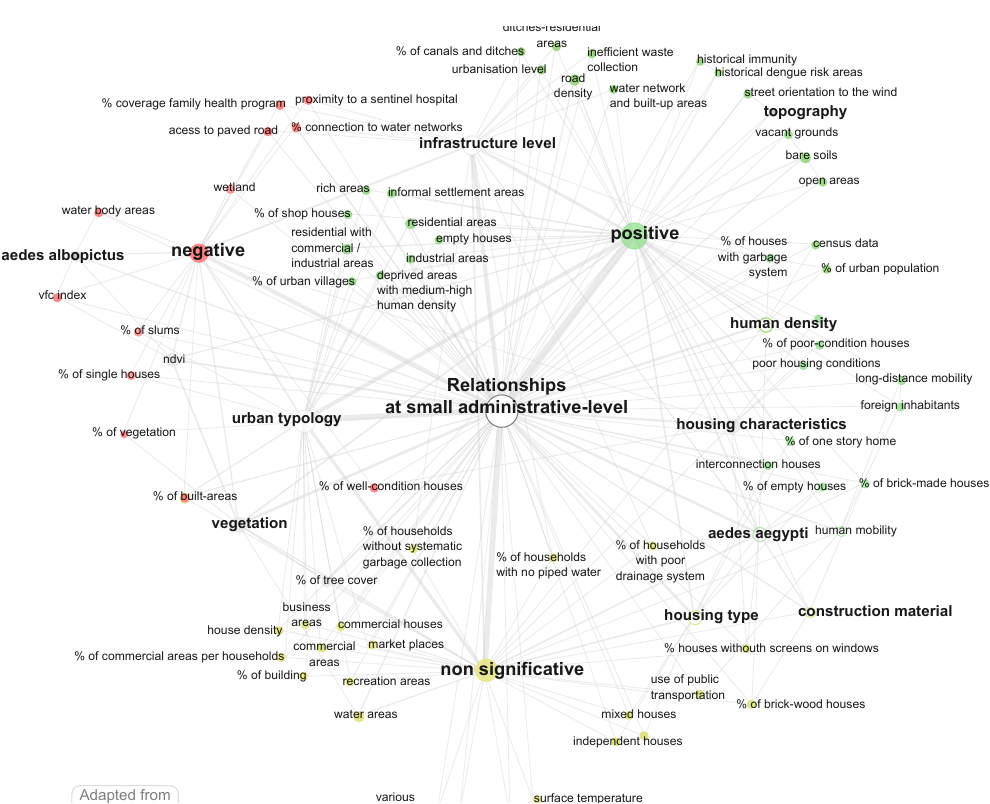
Figure 9. Co-occurrences network mapping of the self-defined keywords related to the landscape factors considered at small administrative-level.